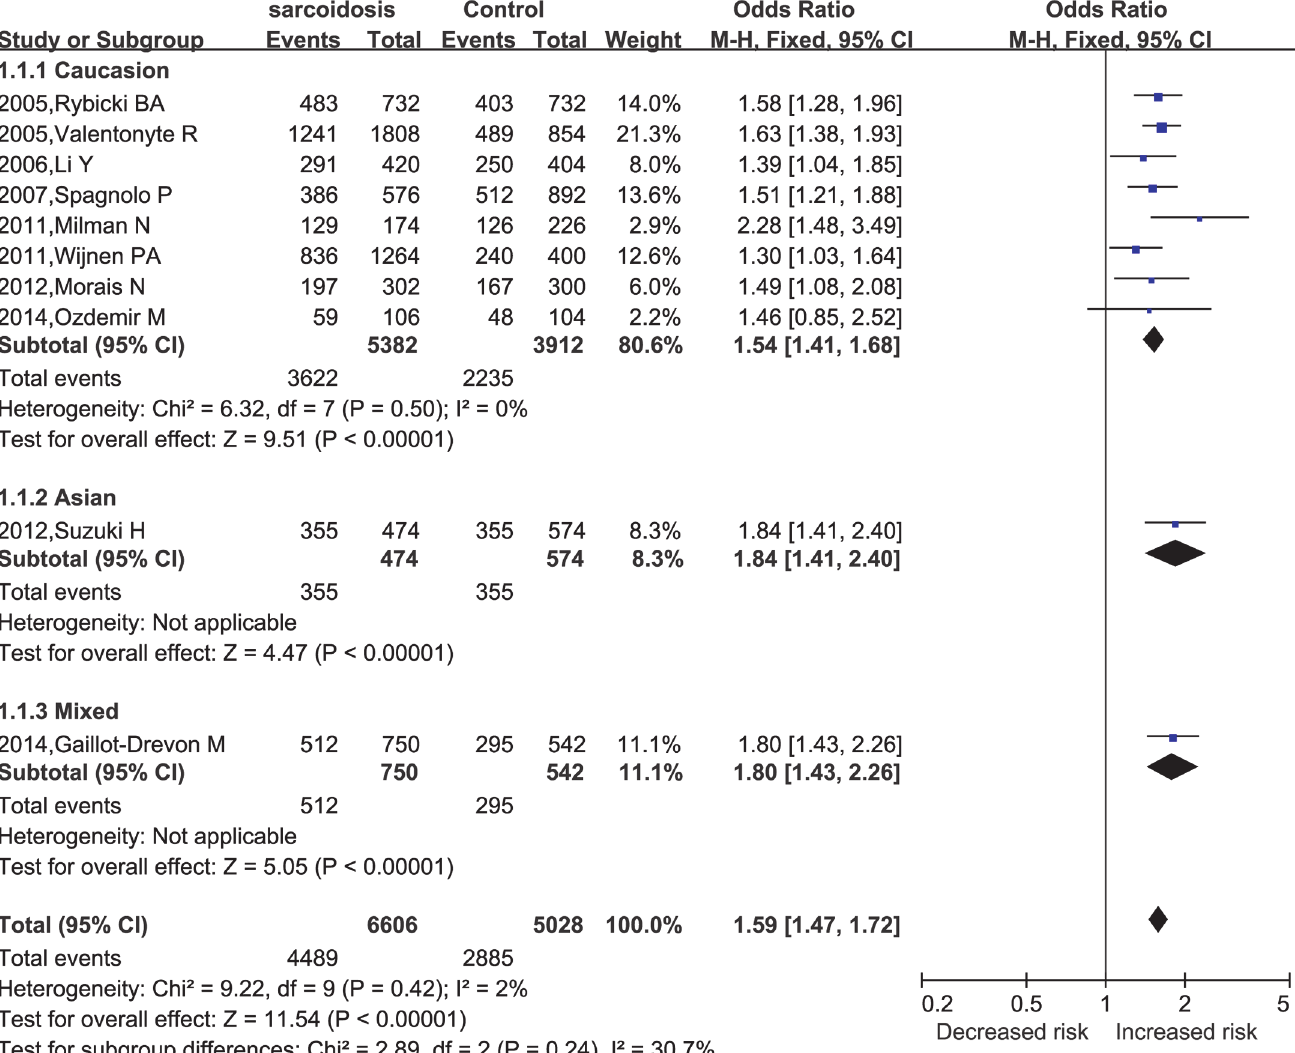
Fig 2. Forest plots of OR with 95% CI for the association of BTNL2 rs2076530 polymorphism and sarcoidosis susceptibility subanalyzed by enthnicity in A vs G.